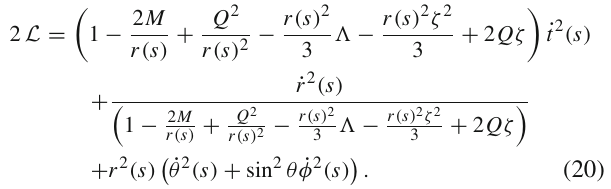
and b is defined as J b = E